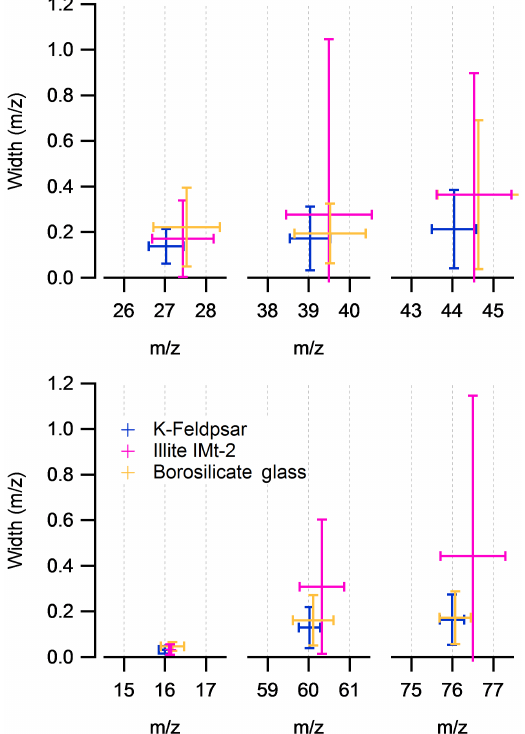
Figure 5. The mean mass-scale position and mass-scale width of three positive ion species and three negative ion species in silicate mineral particles. Measurement is with respect to the K-feldspar calibration. Error bars are 2 SDs of the mean calculated from 800 spectra per sample.